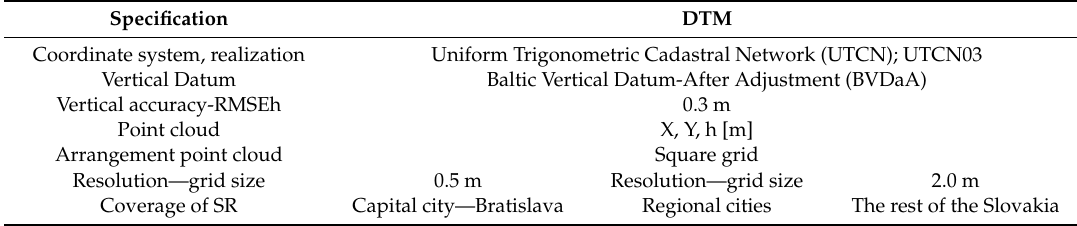
Table 1. Basic parameters DTM from aerial photogrammetry (adapted from geodatastore.sk / katalog / digitalny-model-terenu).